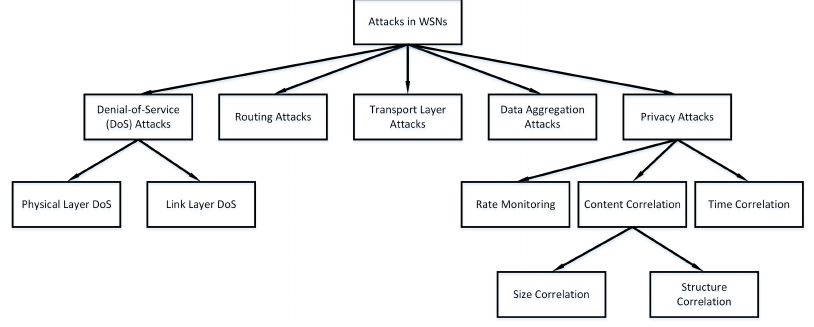
Figure 3. Types of attacks in